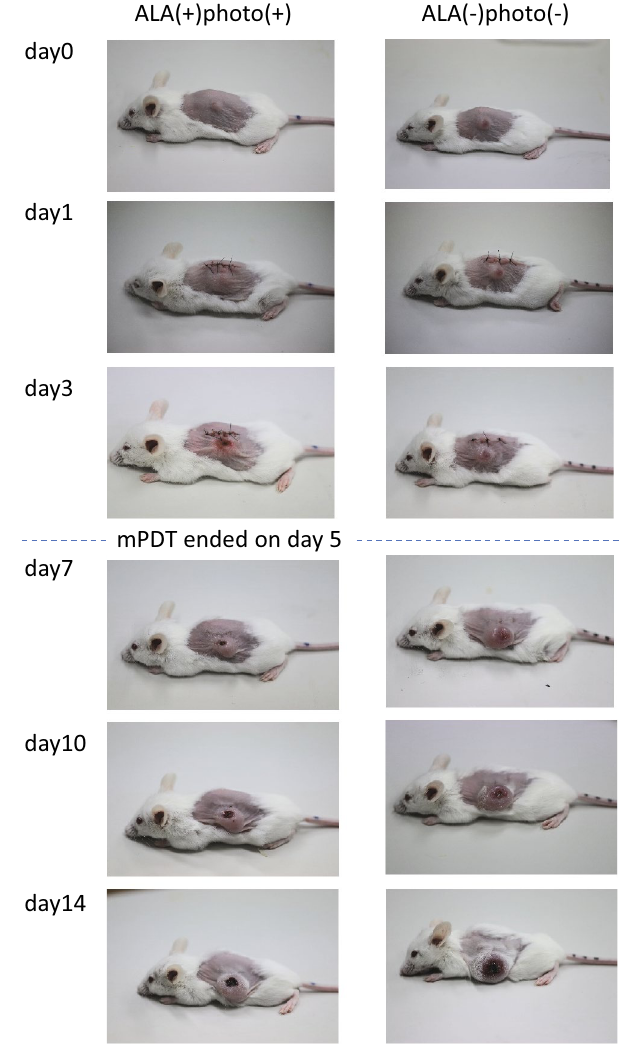
Figure 5. Representative photographs showing temporal changes in tumor